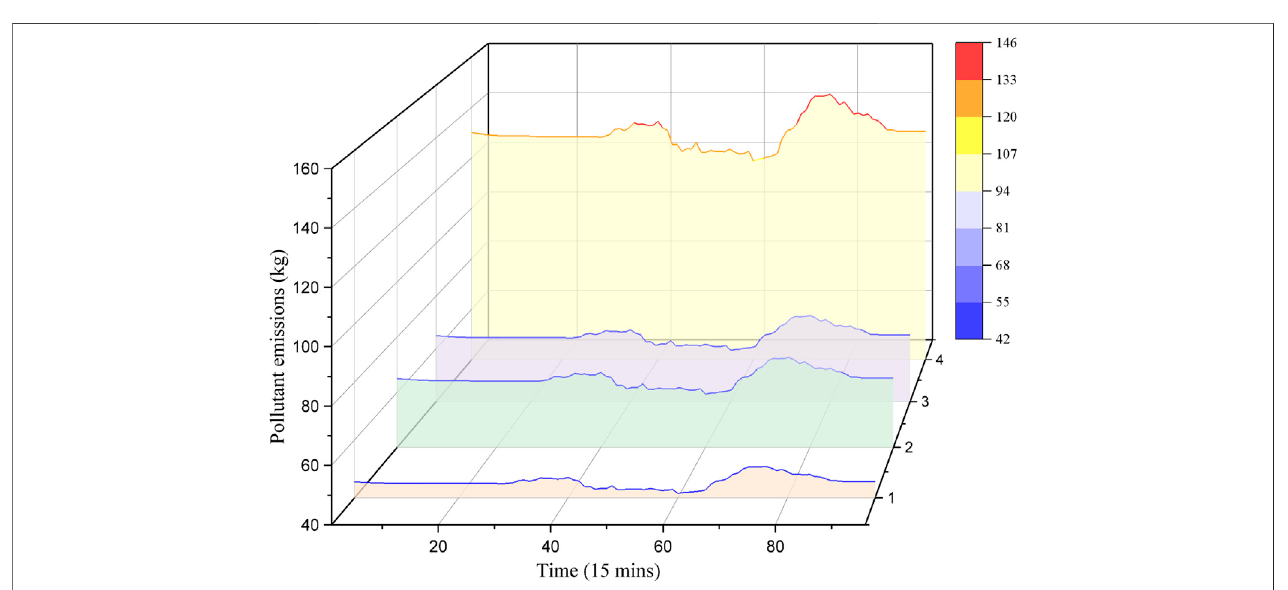
FIGURE 13 | Pollutant emissions before and after ultra-low emission (1: SO 2 after ultra-low emission; 2: NO x after ultra-low emission; 3: SO 2 before ultra-low emission; 4: NO x before ultra-low